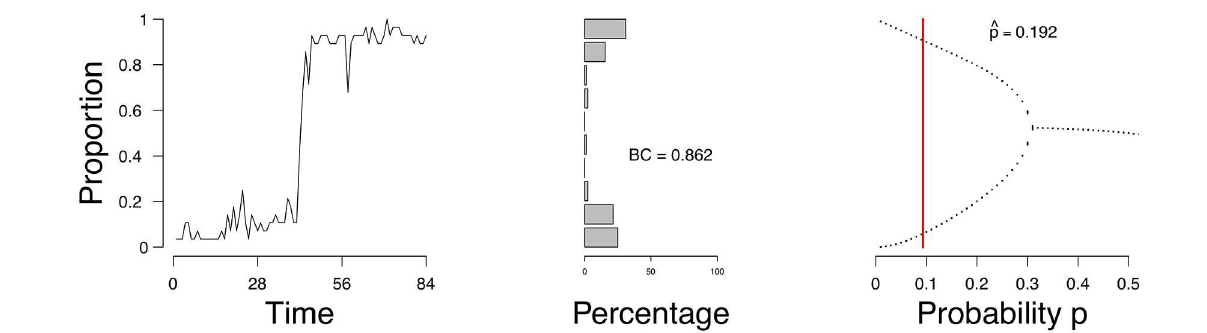
did not significantly differ in age ( W = 831, p = 0.835), and admission period ( W = 755.5, p = 0.131). Under the EU General Data Protection Regulation , we are not allowed to publish raw results. Result figures for all patients can be found online (Kossakowski,